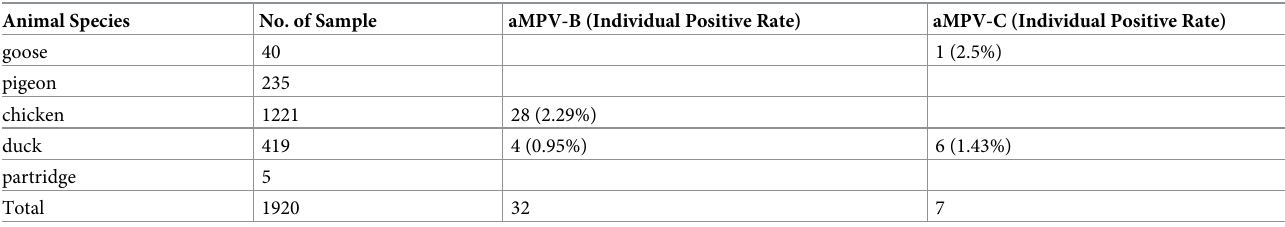
Table 6. The host distribution of 39 positive samples of aMPV. Animal Species No. of